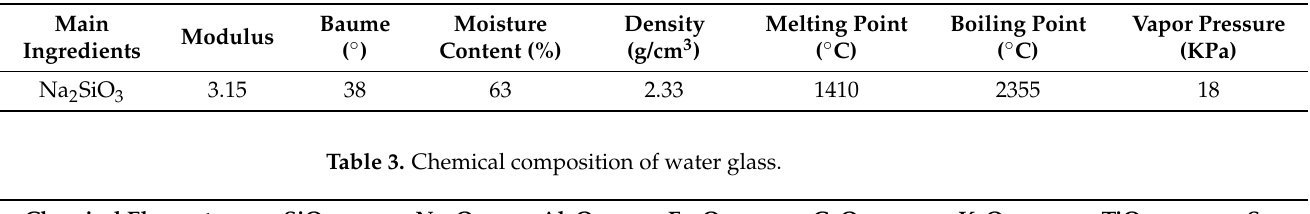
Table 2. Physical performance index of water glass.